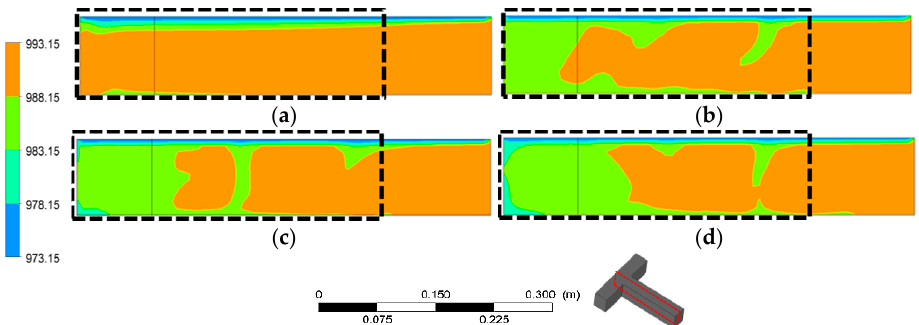
Figure 12. Temperature field in the melt: ( a ) conventional process; ( b ) 100 A; ( c ) 150 A; ( d ) 200 A (unit: K).